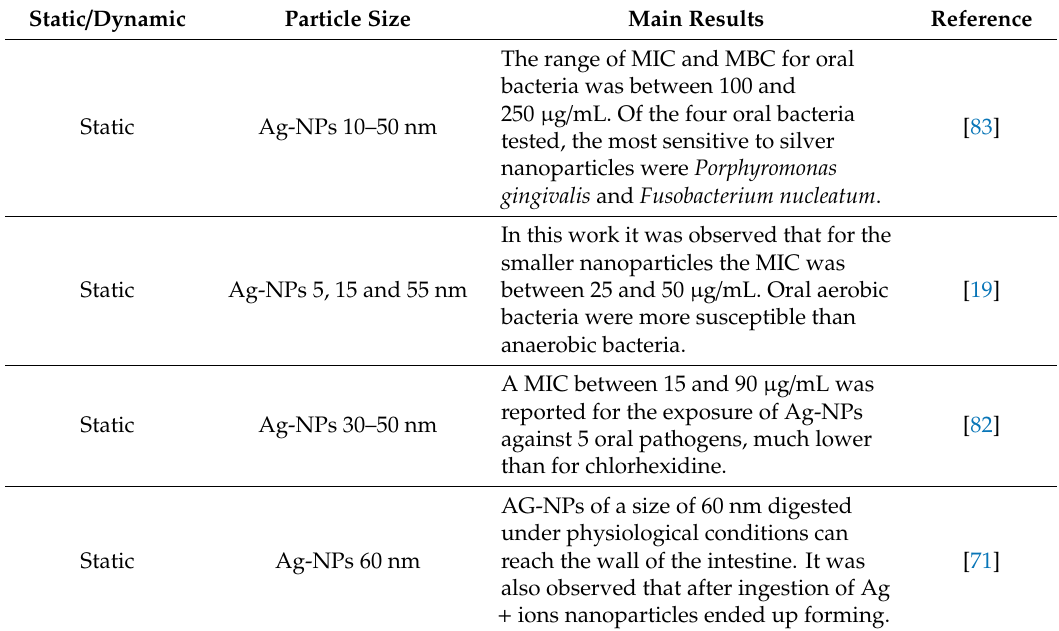
Table 3. Studies in in vitro static and gastrointestinal simulation models regarding silver nanoparticles e ff ects at gut level and